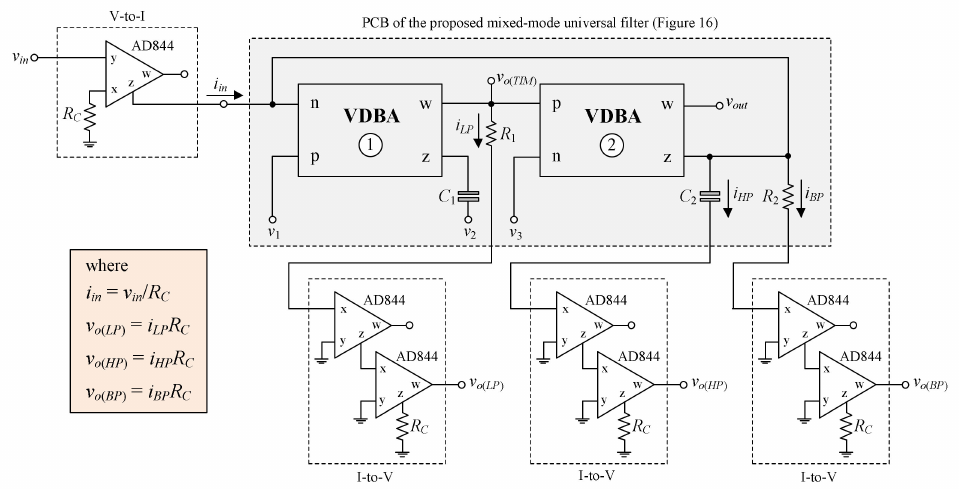
Figure 17. Experimental setup for measuring the CM, TAM, and TIM filter